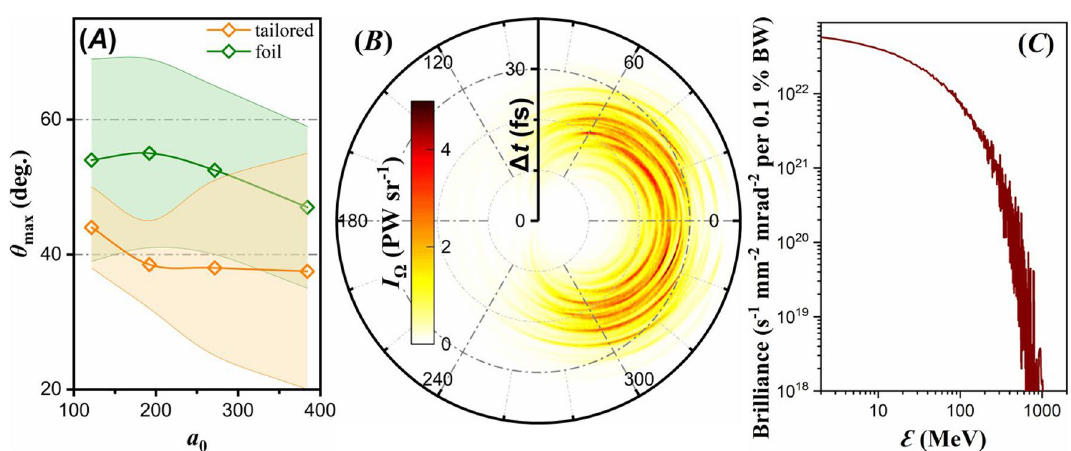
Figure 7. ( A ) Angle of the peak γ -photon radiant intensity as a function of a 0 . The tailored and foil target cases are shown by the orange and green lines respectively. The ranges for both cases show the region where the radiant intensity is above 90% of its peak value. ( B ) Radiant intensity of γ -photons measured within a full-angle divergence of 10 o with respect to the polarization plane, as a function of time-of-flight difference. ( C ) Brilliance for the 10PW laser case interacting with a lithium tailored target. The corresponding solid angle is at 37.5 o with respect to the laser propagation axis, with a cone full angle of 10 o